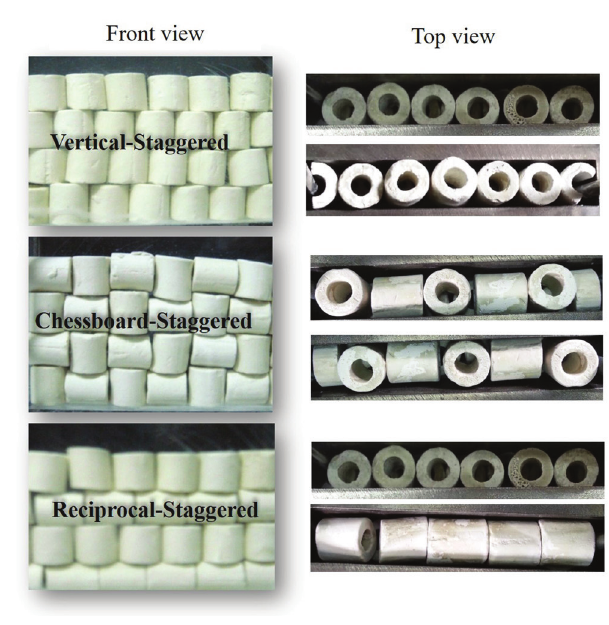
Fig. 3 – Three well-defined packing